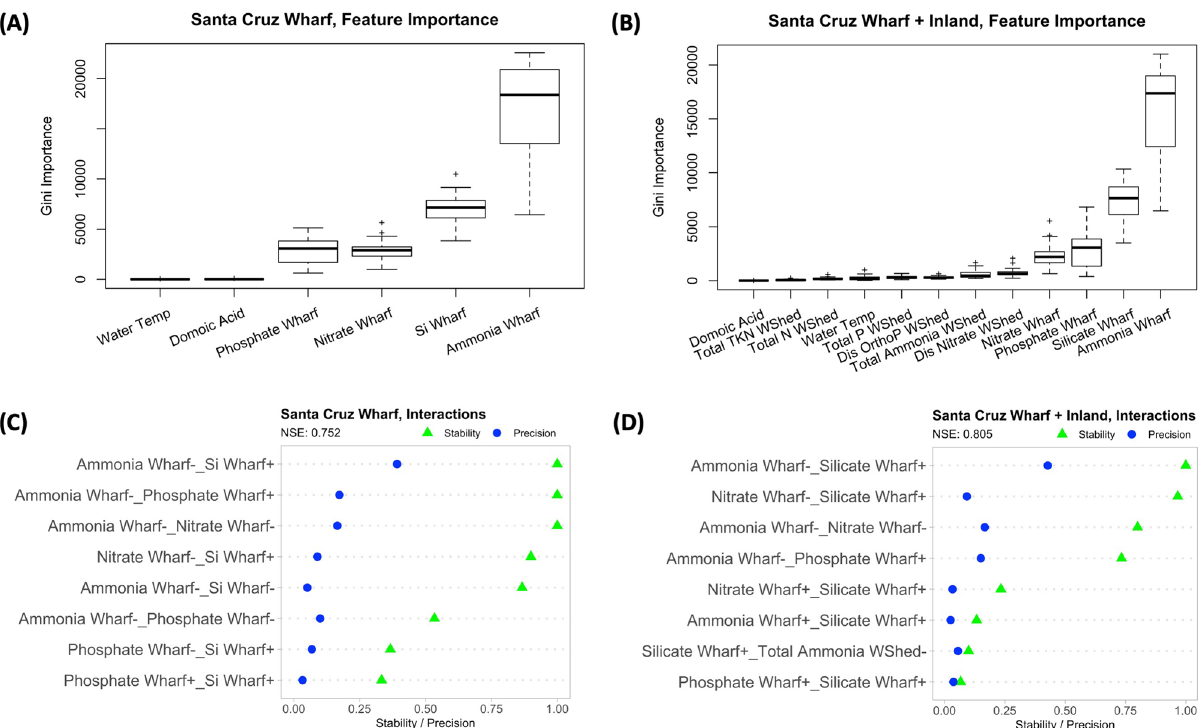
Figure 2. ( A and B ) Gini Importance of explanatory variables for iterative random forest models utilizing (left) Santa Cruz Wharf (SCW) data and (right) SCW + inland data. ( C and D ) The 8 most stable interactions recovered by iRF with the highest NSE utilizing (left) Santa Cruz Wharf (SCW) data and (right) SCW + inland data. Black triangles represent stability values while blue dots represent precision